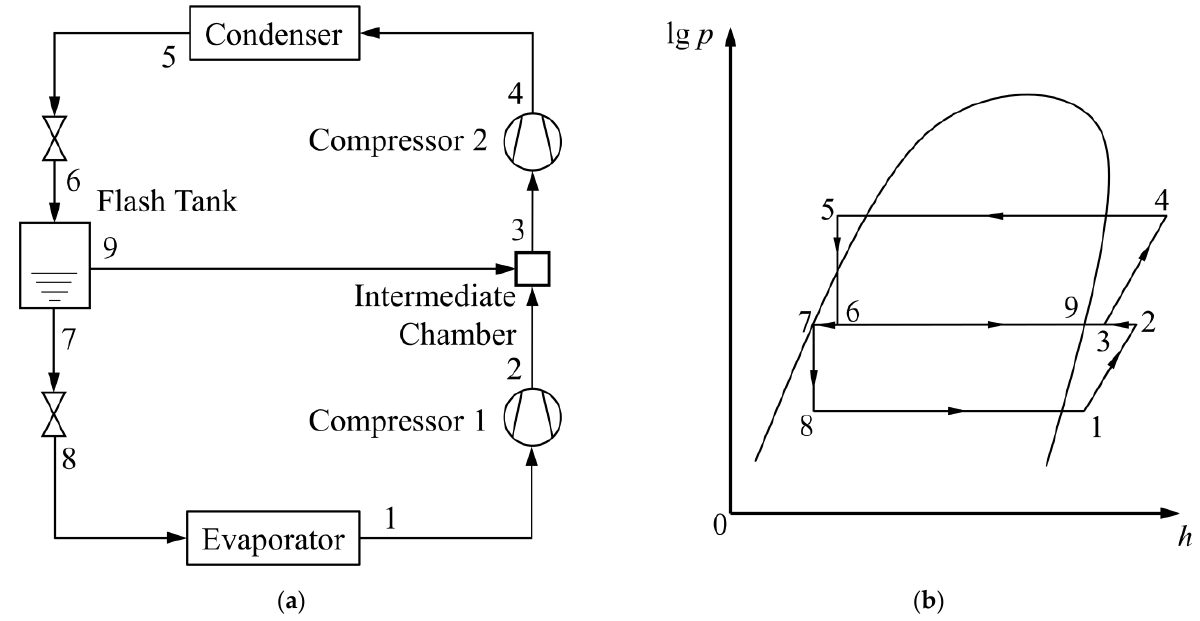
Figure 2. Schematic diagram and pressure-enthalpy diagram of two-stage compression with vapor injection system: ( a ) schematic diagram of two-stage compression with vapor injection system; ( b ) pressure-enthalpy diagram of two-stage compression with vapor injection system.